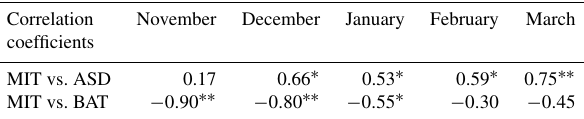
Table 3. Correlation coefficients between maximum ice thick- ness (MIT) and average snow depth (ASD) and air temperature on bank (BAT) with a dataset size of 120 stations. The asterisks indi- cate the significant level of correlation coefficients: ∗∗ means sig- nificant at 99% level ( p < 0 . 01), and ∗ means significant at 95% level ( p < 0 . 05).